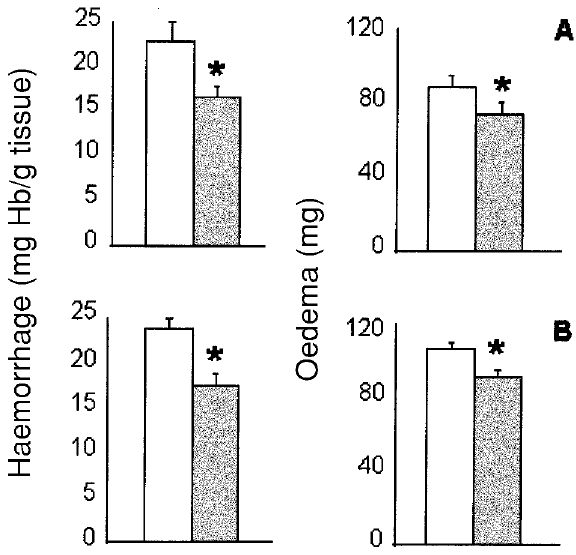
FIG. 4. Effect of treatments with (A) methysergide and (B) morphine on B. jararaca -induced haemorrhage and oedema. Mice were treated with (A) methysergide (0.8mg/kg,s.c.) or (B) morphine (30mg/kg,s.c.), 30min before B. jararaca venom injection (5 m g) into the foot pad. Haemorrhage and oedema in treated animals (dark bars) were compared with results obtained in saline treated control groups (white bars). Mean ± SE. * p < 0.05.